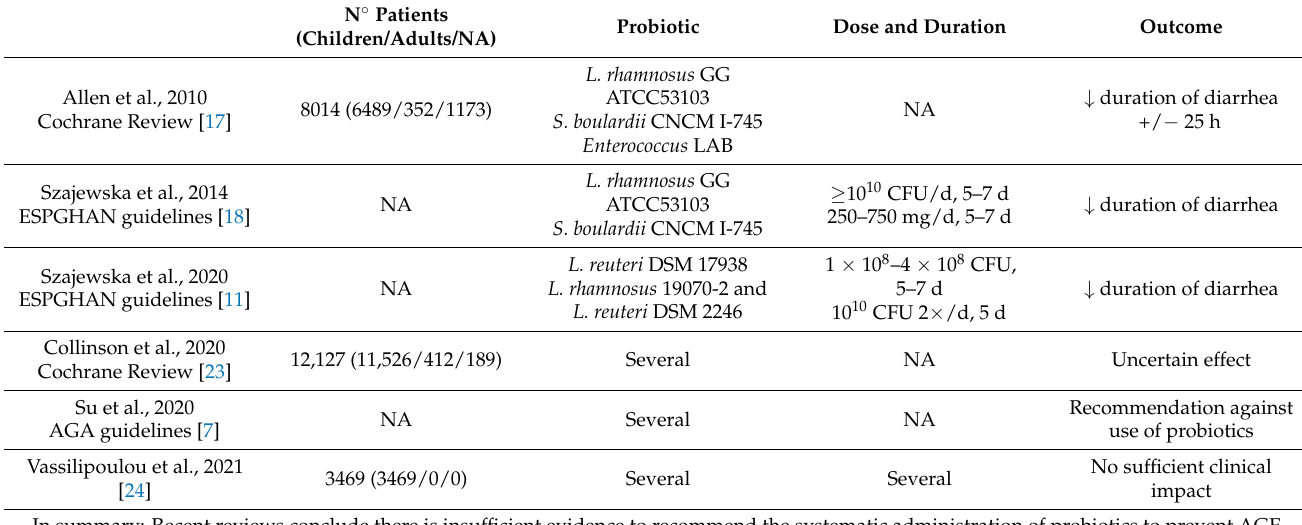
Table 2. Meta-analyses and systematic reviews on probiotics in acute